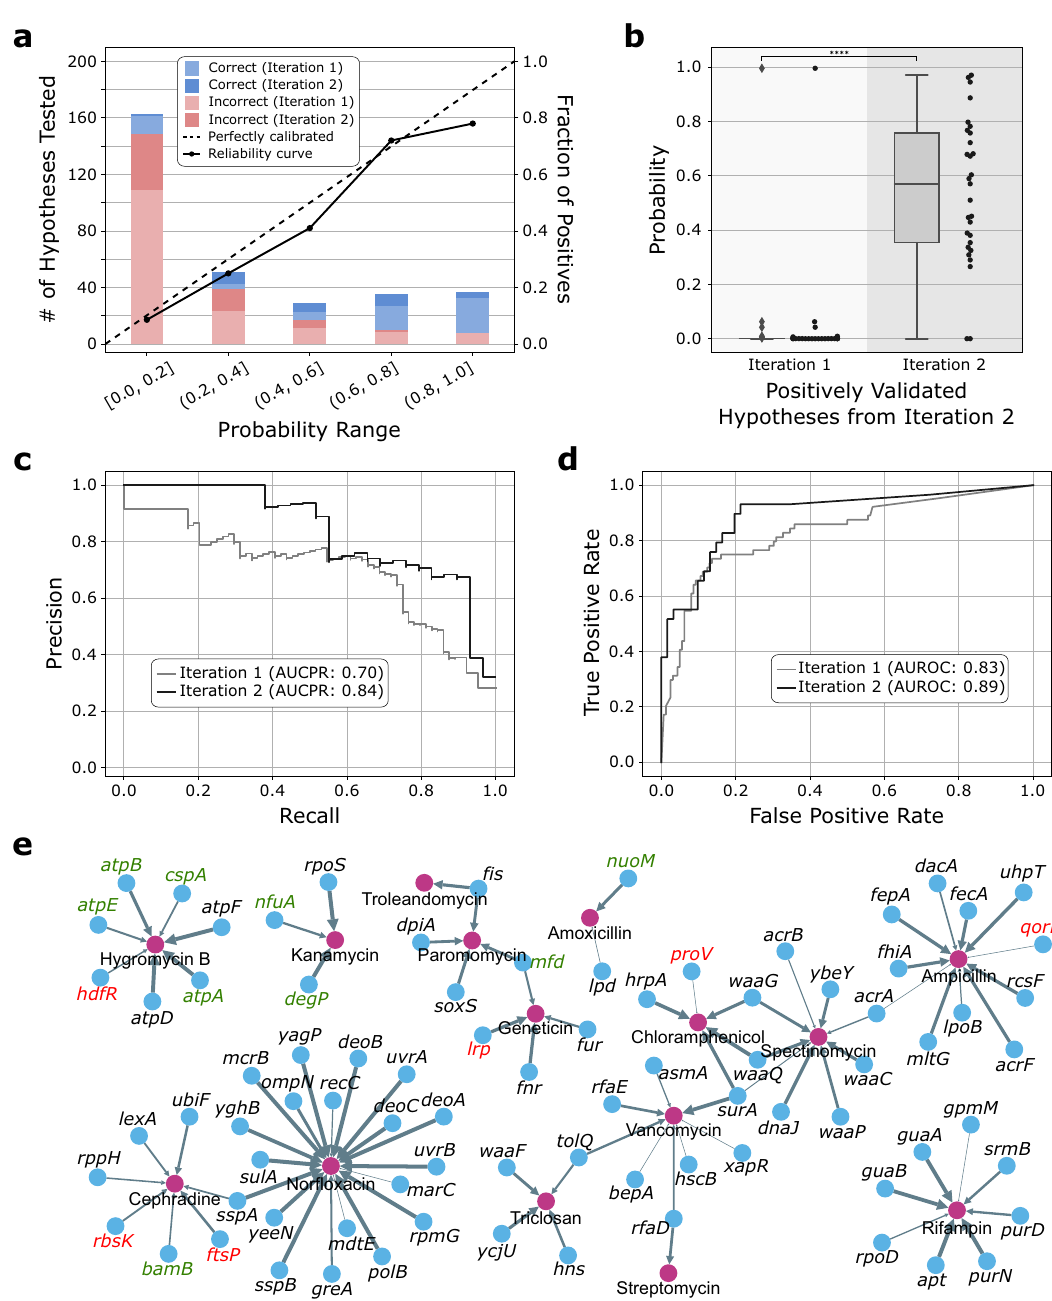
Fig. 5 Accelerated missing link discovery through iterative learning. a A high correlation between the probability assignment by the hypothesis generator and forward experimental validation (226 and 90 validated hypotheses from the fi rst and second iteration, respectively; R 2 = 0.94). b The probability distribution of the positively validated hypotheses from the second iteration (i.e., dark blue bar in a ) compared to the probability of the same hypotheses from the fi rst iteration ( n = 29 positively validated second iteration hypotheses). Updating the knowledge graph with the validated hypotheses in the fi rst iteration (i.e., light blue and red bars in a ) and re-training of the hypothesis generator led to the 14-fold probability increase (0.55 vs. 0.04, respectively, p value = 1.1 × 10 − 11 ), which in turn enabled the discovery that would not have been possible with only one iteration of hypothesis generation. The box represents the interquartile range, the middle line represents the median, the whisker line extends from minimum to maximum values, and the diamond represents outliers. The p value was calculated using the two-sided t -test. c , d The precision-recall (PR) and receiver operating characteristic (ROC) curves of the generated hypotheses compared against our wet-lab validation results. The AUCPR and AUROC of the second iteration hypotheses increased by 19.4% and 7.3%, respectively, when compared to the fi rst iteration hypotheses. e We predicted and validated 64 CRA hypotheses from iteration 1 and 29 CRA hypotheses from iteration 2 for a total of 83 E. coli genes (blue node) that confer resistance (gray arrow) to one or more of 15 antibiotics (purple node). Genes with green and red labels indicate previously unknown genes that are not associated with antibiotic resistance in E. coli (9 genes) or any microbe (6 genes), respectively. The edge thickness is proportional to the KIDS predicted